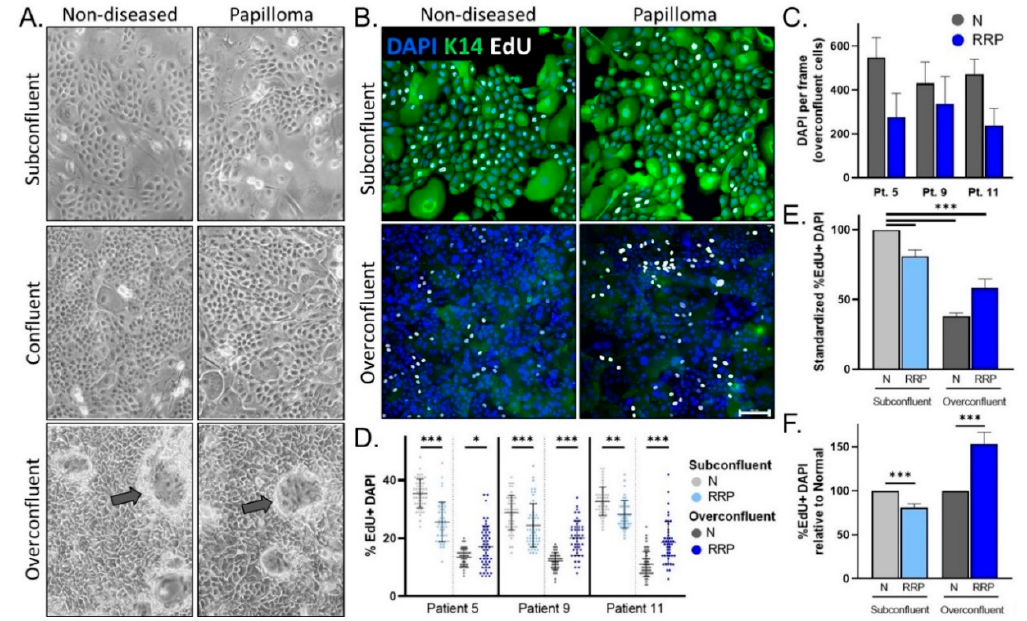
Figure 2. ( A ) Representative 10× images of 2D matched papilloma and non-diseased primary cells at subconfluency (top), confluency (middle), and overconfluency (bottom) states. Arrows depict differentiating cells growing upwards. ( B ) Immunofluorescence (IF) analysis for the basal cell marker K14, EdU, and DAPI in papilloma and matched non-diseased cells. Scale bar 100 μ m. ( C ) Quantification of DAPI nuclei per frame at overconfluency demonstrates intra-sample variability and a trend to decreased DAPI counts in matched papilloma (RRP) versus non-diseased (N) primary cells. ( D ) Percentage of EdU+ DAPI+ nuclei in papilloma and non-diseased cells at subconfluency (n = 44–59 frames) and overconfluency (n = 38–51 frames) across three patients. ( E ) Average% EdU+ DAPI+ nuclei across patients relative to non-diseased cells in standard cell culture conditions (subconfluency) show a decrease in proliferation after reaching confluency. ( F ) Compared to non-diseased cells, papilloma cells have slightly decreased EdU incorporation (19%) at subconfluency, whereas their proliferation significantly increases (53%) at overconfluency. * = p < 0.05, ** = p < 0.01, *** = p < 0.001.